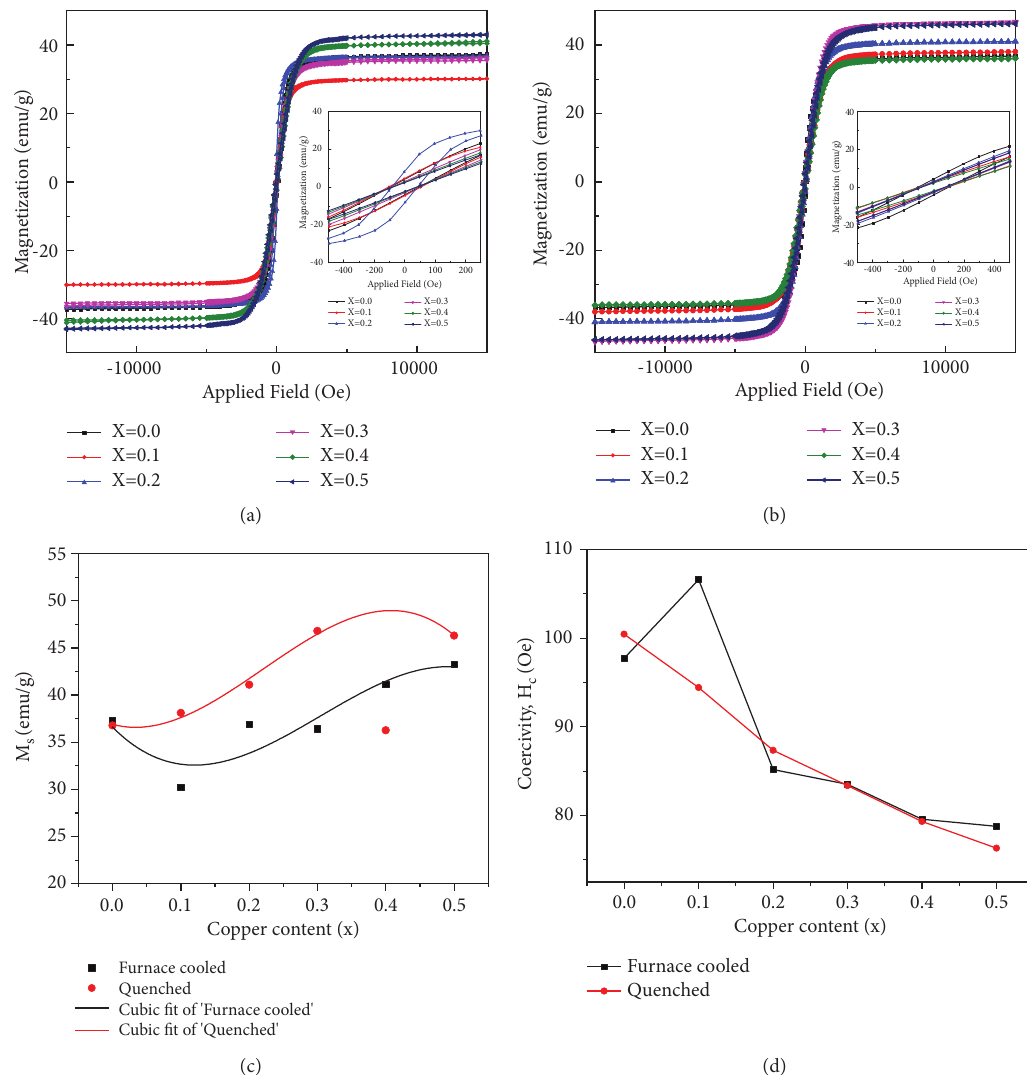
Figure 3: M-H curve of (a) furnace-cooled and (b) quenched Mg � 0–0.5) samples. Variation of (c) saturation magnetization 1-x Cu x Fe 2 O 4 ( x and (d) coercivity of furnace-cooled and quenched Mg-Cu ferrites with Cu content. Table 2: Saturation magnetization, coercivity, and remanence measured by VSM at room temperature for furnace-cooled and quenched Mg 1-x Cu x Fe 2 O 4 after sintering at 1200 ° C.